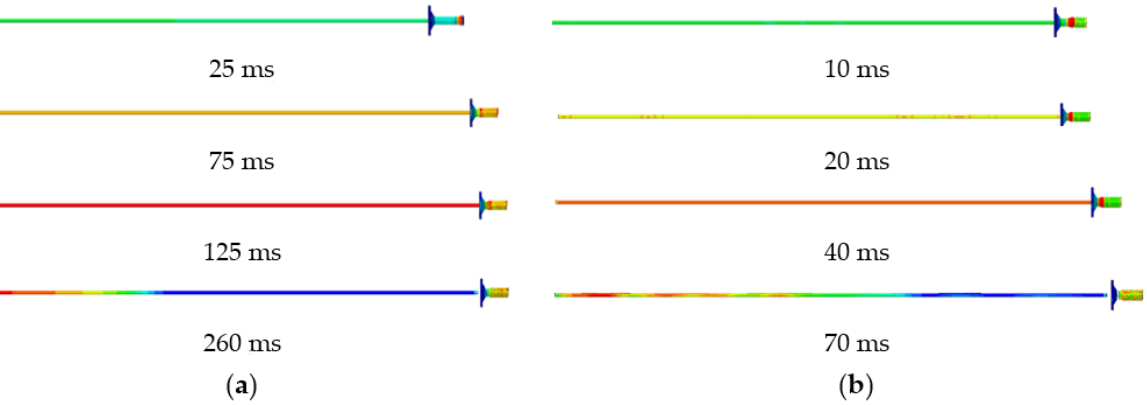
Figure 10. Deformation of constant resistance energy-absorbing anti-scouring anchor rod by force. ( a ) Conventional anchor, ( b ) constant resistance energy-absorbing anti-scour anchor.